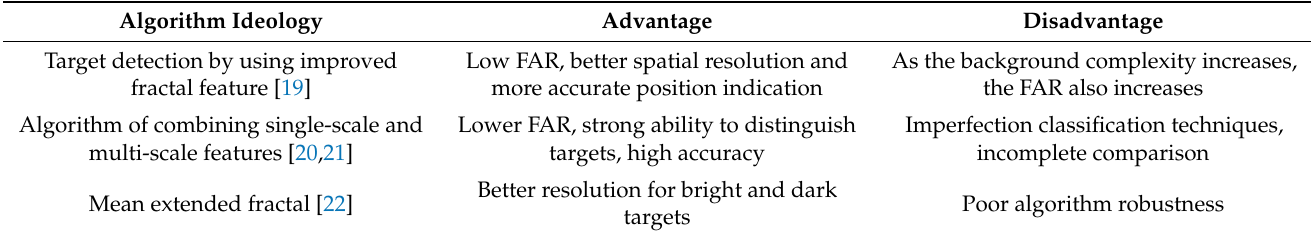
Table 3. A brief overview of the target detection algorithms based on image texture